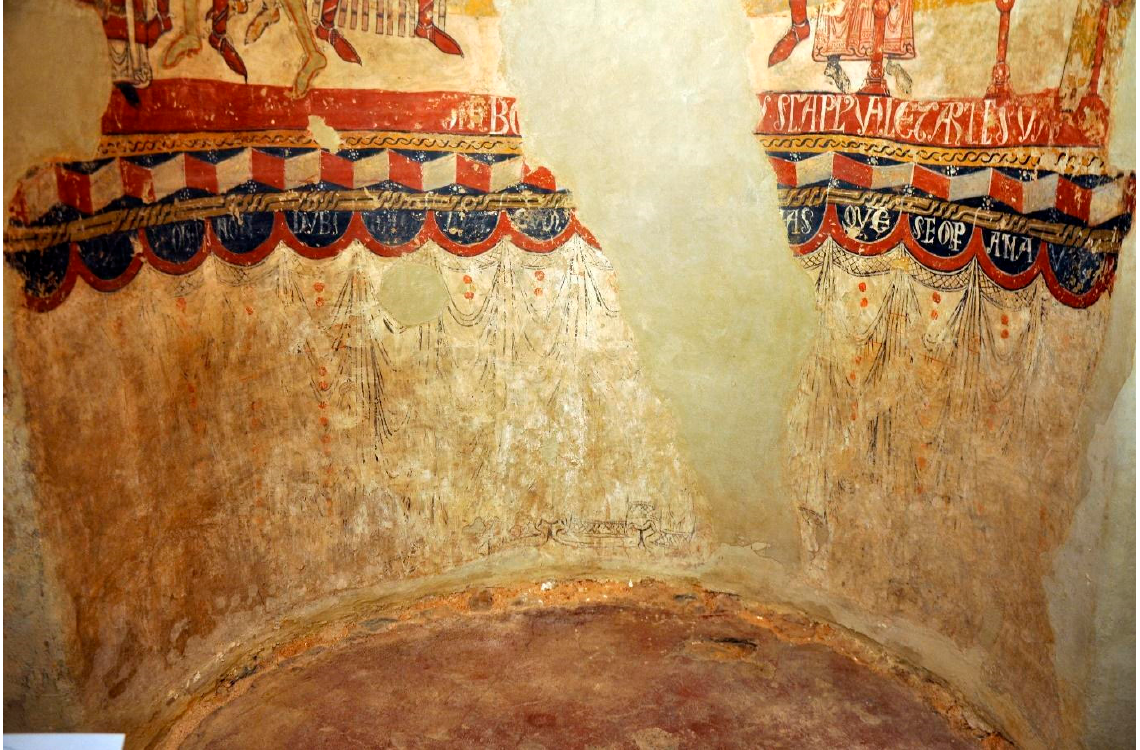
Figure 5. Paintings at Santa Maria de Terrassa. Inscriptions in the lower register. © Photo: Carles Sánchez.